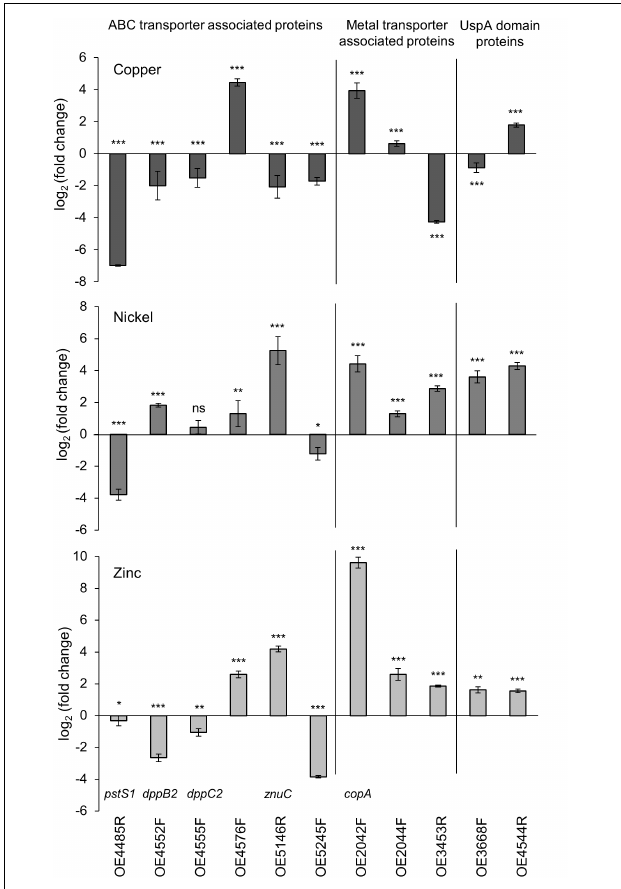
FIGURE 5 | Comparative qRT-PCR analyses of metal treated and untreated planktonic cells. Gene expression of several ABC transporter- and metal transporter encoding genes as well as two UspA domain genes was relative quantified. Relative quantification in (A) copper-treated, (B) nickel-treated, and (C) zinc-treated cells compared to untreated cells. C T -values of the target genes were normalized to the housekeeping gene rpoB1 . Significance of changes in the amount of transcripts was assessed by t -test (ns, not significant, ∗ significant = P < 0.05, ∗∗ highly significant = P < 0.01, ∗∗∗ extremely significant = P < 0.001). For description of genes and the corresponding fold change in gene expression see Table 3